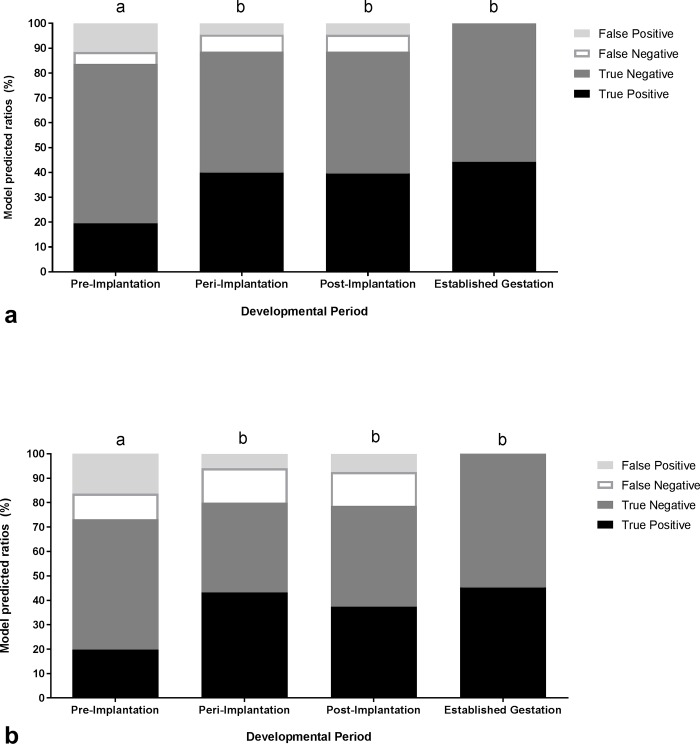
Predicted ratios of each category; true positive (black segment), true negative (dark grey segment), false negative (white segment) and false positive (light grey segment), generated from an Ordinal Logistic Regression for the accuracy of using TRUS to detect pregnancy (a) and multiples per ewe (b) during pre-implantation (day 12/14), peri-implantation (day 17/19), post-implantation (day 28) in reference to results obtained by TCUS during established gestation (day 54).